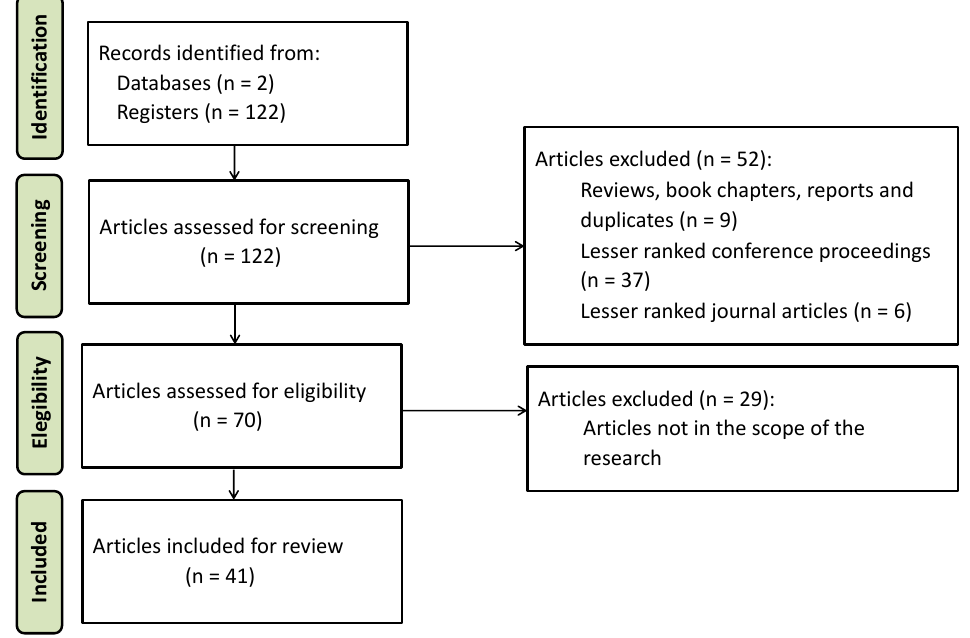
Figure 1. PRISMA flow diagram of the followed screening procedures.